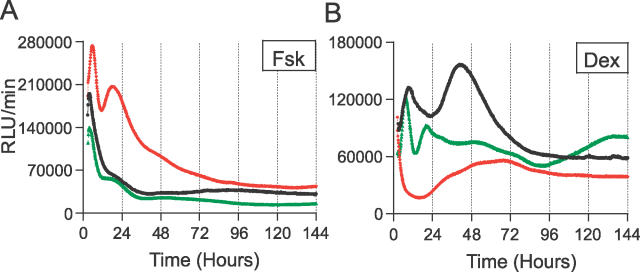
Representative Traces of the Rat-1 Cells Stably Transfected with Psv40::dLucTime 0 is the onset of each treatment. Traces from three separate transfections are shown. (A) Rat-1/Psv40::dLuc cells treated with 10 μM Fsk for 2 h. (B) Rat-1/Psv40::dLuc cells treated with 100 nM Dex for 2 h.